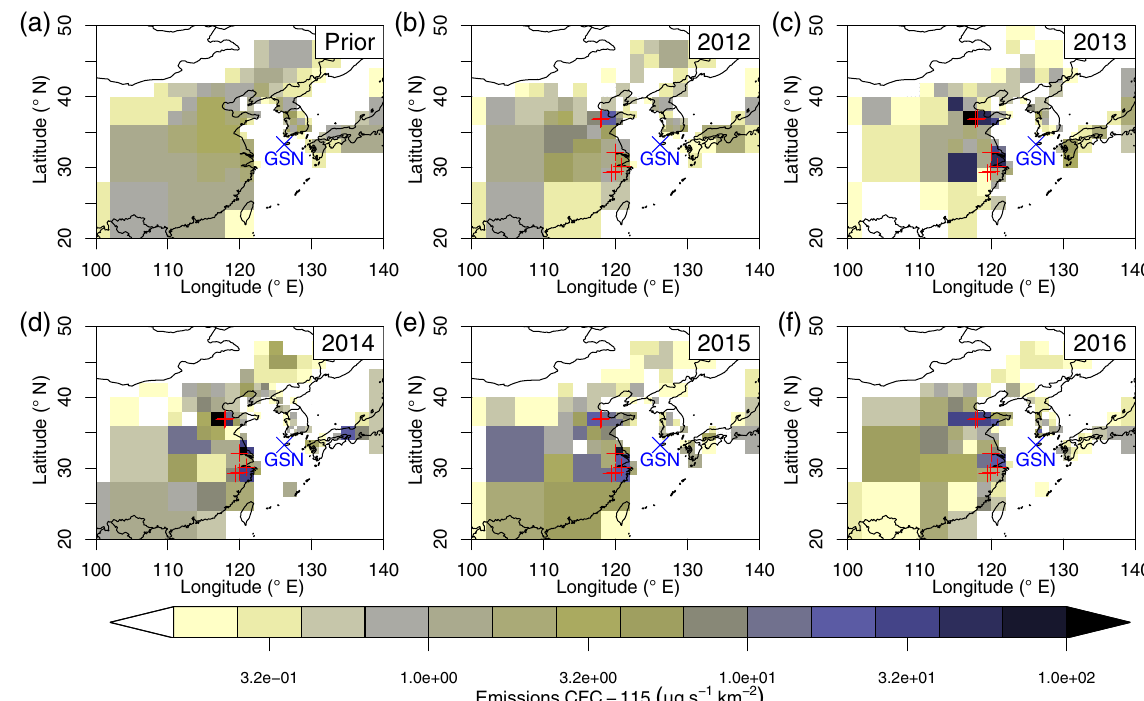
Figure 9. Emissions of CFC-115 from northeastern Asia as estimated with inverse modeling using the CFC-115 observations at Gosan (marked with a blue cross). (a) Common prior distribution; (b–f) posterior distribution for the years 2012 to 2016. Red plus signs mark the location of known HFC-125 factories, which are hypothesized to be potential sources of